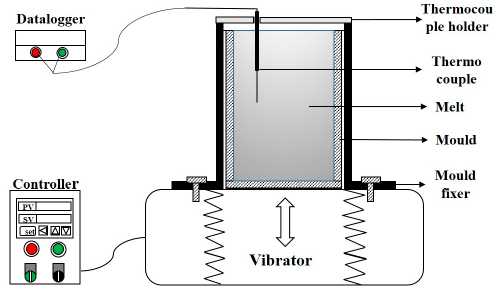
Figure 1. The schematic of a mechanical vibration device. Table 1. Chemical compositions of Al-Si-Fe alloys Mass Fraction/% Alloy Si Fe Al As-cast 6.62 2.86 As-vibration 6.47 2.87